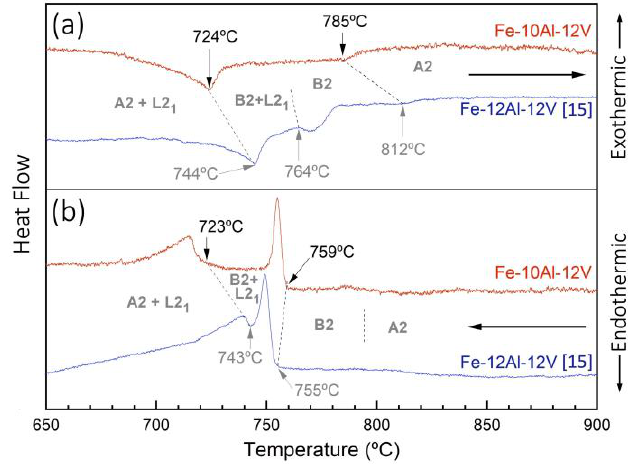
Figure 4. DSC in Fe-10Al-12V and Fe-12Al-12V [15] alloys. Heating ( a ) and cooling ( b ) at 5 °C/min.